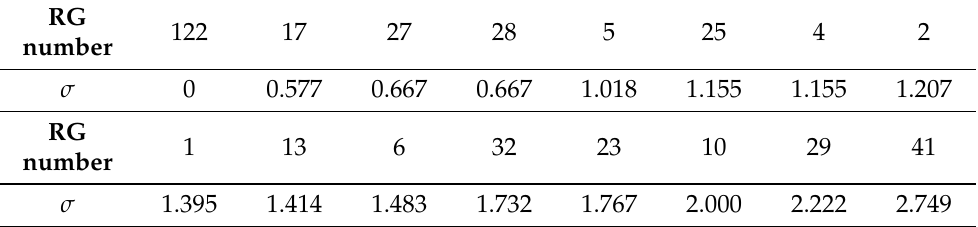
Table 8. Distribution of the standard deviation of w spi versus different types of